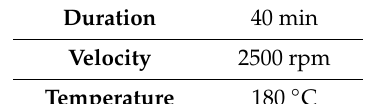
Table 3. Bitumen Mixing characteristics.